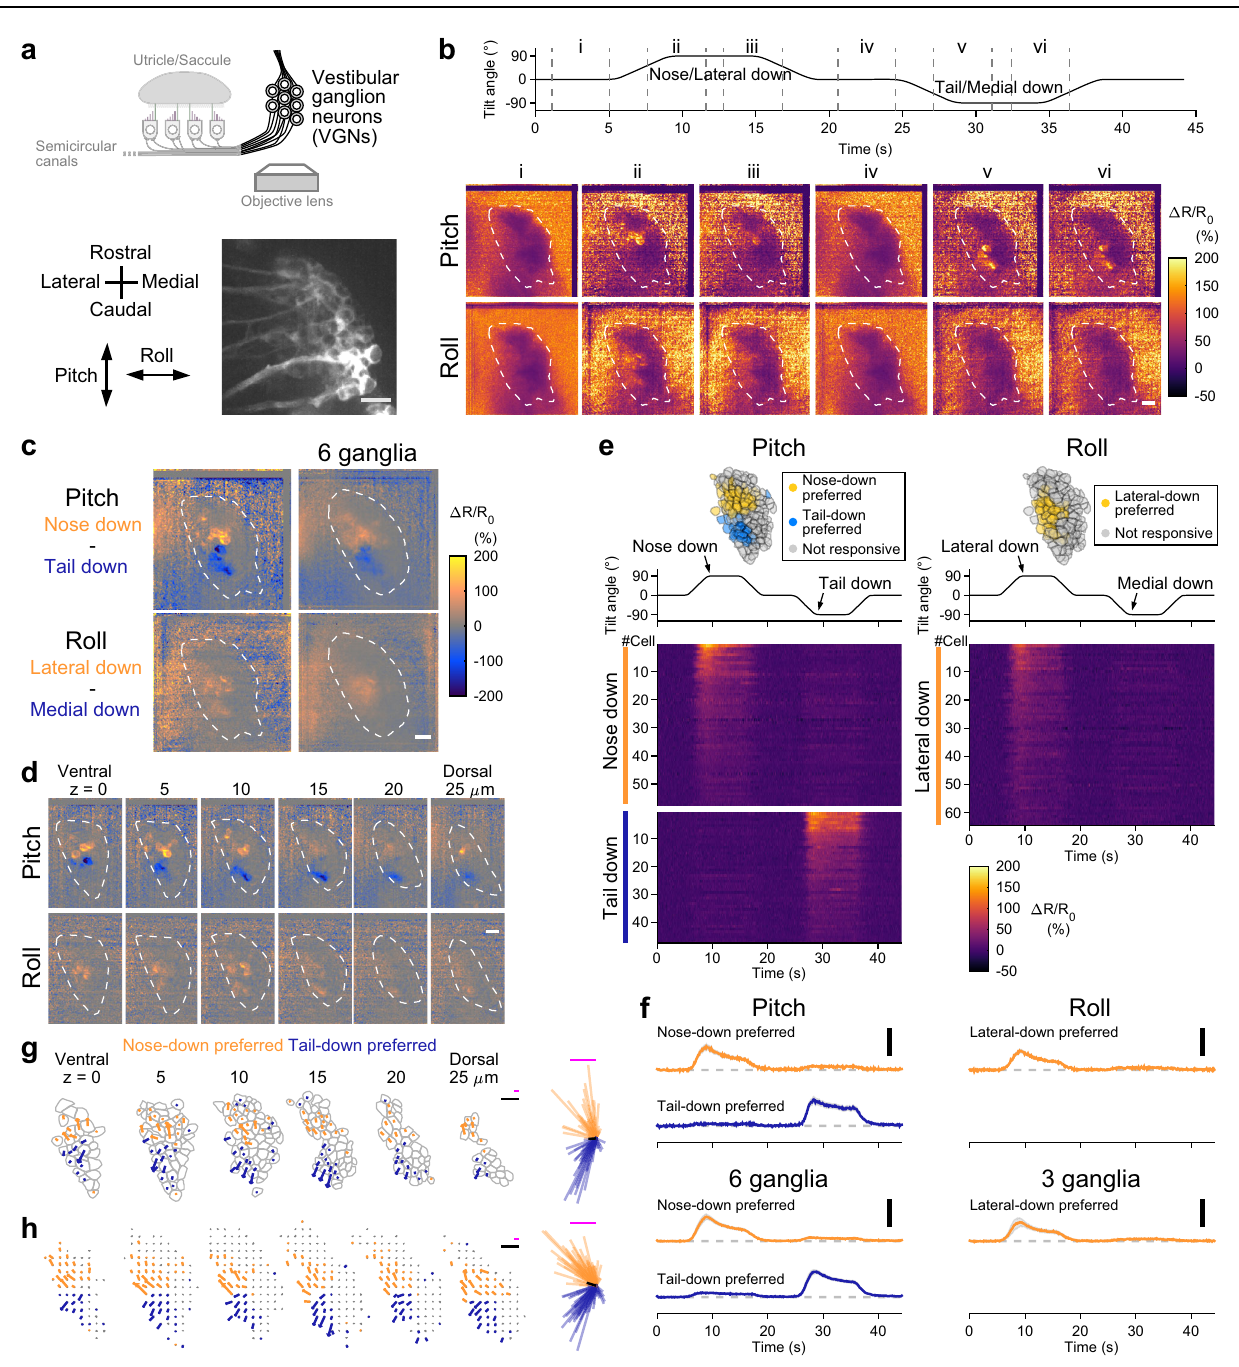
responses (bottom). f Mean Δ R / R 0 responses across VGNs in each preference groupinasingleVG(top).NumberofcellsisreportedintheSupplementaryFig.4 legend.Meanresponsesofeachgroup(bottom,6VGforpitch;3leftVGforroll;3 right VG are shown in Supplementary Fig. 4e). SEM is shown in gray. Tilt time course is the same as in ( e ). Scale bar: 50% Δ R / R 0 . g VGN response vectors. Orientation and length of arrows indicate preferred direction and Δ R / R 0 ampli- tude, respectively. Responses with amplitude larger than 10% Δ R / R 0 are shown. Gray:VGN contours. Magenta scale bar: 50% Δ R / R 0 . Black scale bar: 10 μ m. (right- end panel) All response vectors aligned together. Black bar: mean response vector. Magenta scale bar: 50% Δ R / R 0 . h Summary of VGN response vectors from 6 ganglia. Mean response vectors per grid (see “ Methods ” ). Arrows and gray dots show mean response vectors with amplitude larger or not larger than 10% Δ R / R 0 , respectively. Colors and scale bars are the same as in ( g ). Source data are pro- vided as a Source Data fi